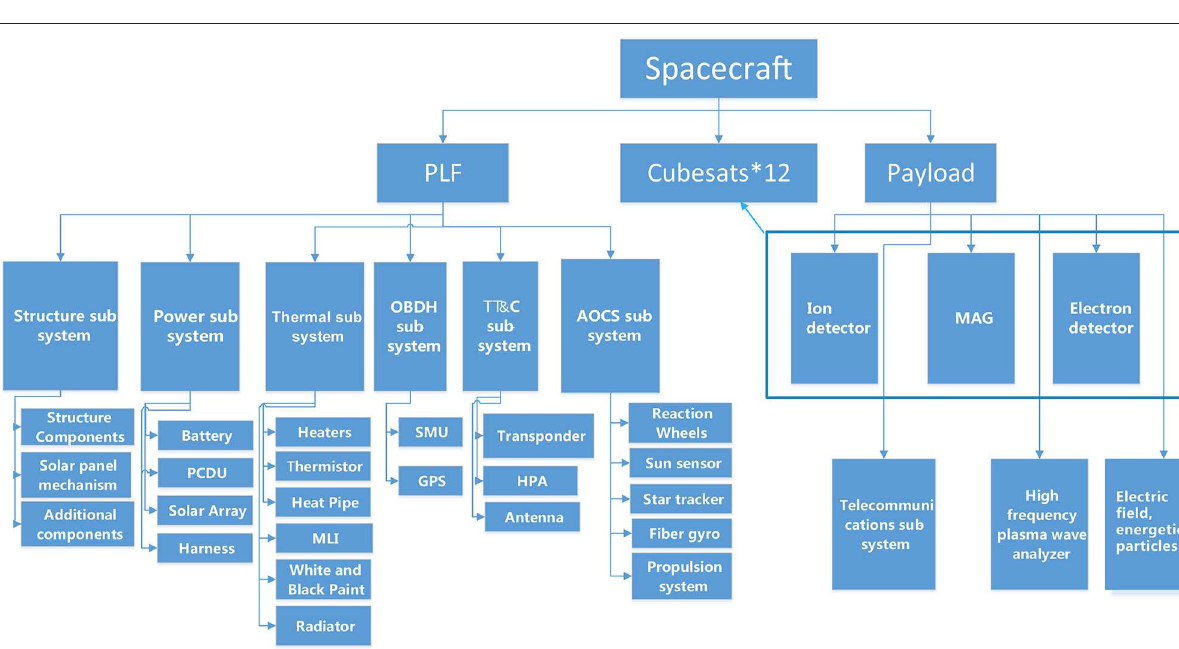
and one electron sensor. The energy range of the measured proton is 50 keV 4 MeV, the field-of-view is 40 ◦ , and the − energy resolution is 20%. The energy range of the electrons is 50 keV 400 keV, the field-of-view is 30 ◦ , and the energy − resolution is